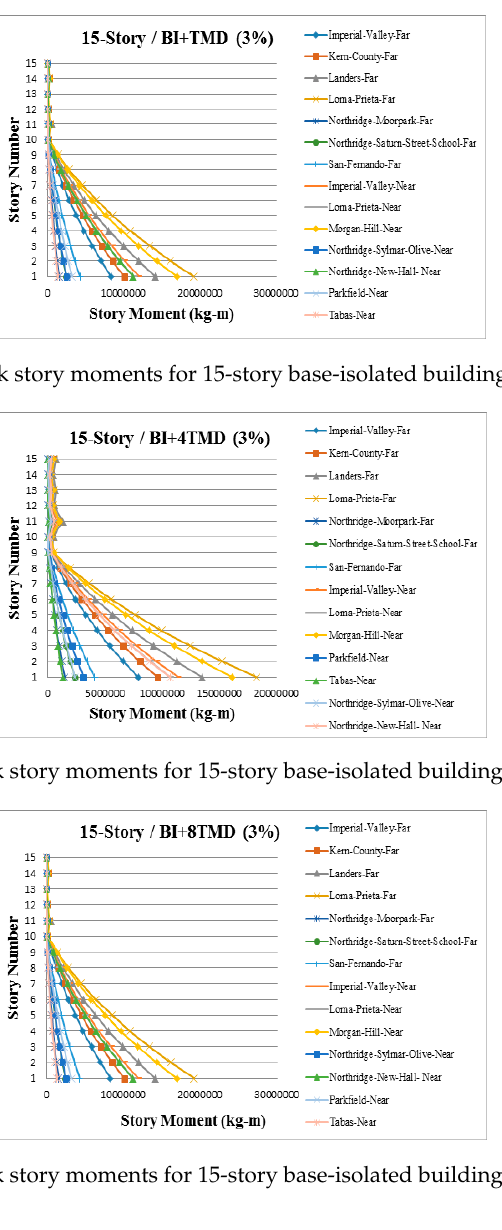
Figure A19. Peak story moments for 15-story fixed-base building with 1 TMD.